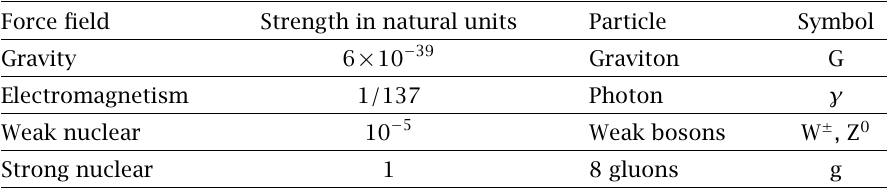
Table 1 . Particles of force fields (bosons).